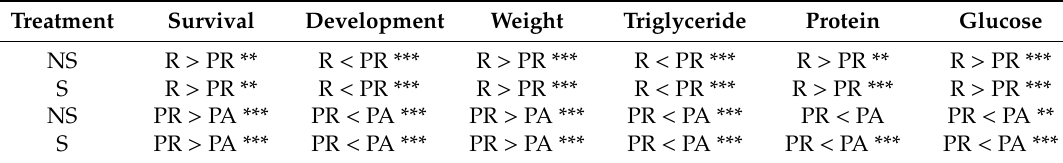
Table 1. The di ff erence in larvae phenotypes based on the diet. Comparison of larvae life history traits and metabolic phenotypes between larvae, from all 10 genetic lines, raised on regular lab diet (R), peach diet (PR), and autoclaved peach diet (PA). NS stands for non-sterilized larvae, S stands for sterilized larvae. Asterisks indicate the uncorrected significance of comparisons p < 0.001 *** and p < 0.01 **. Treatment Survival Development Weight Protein